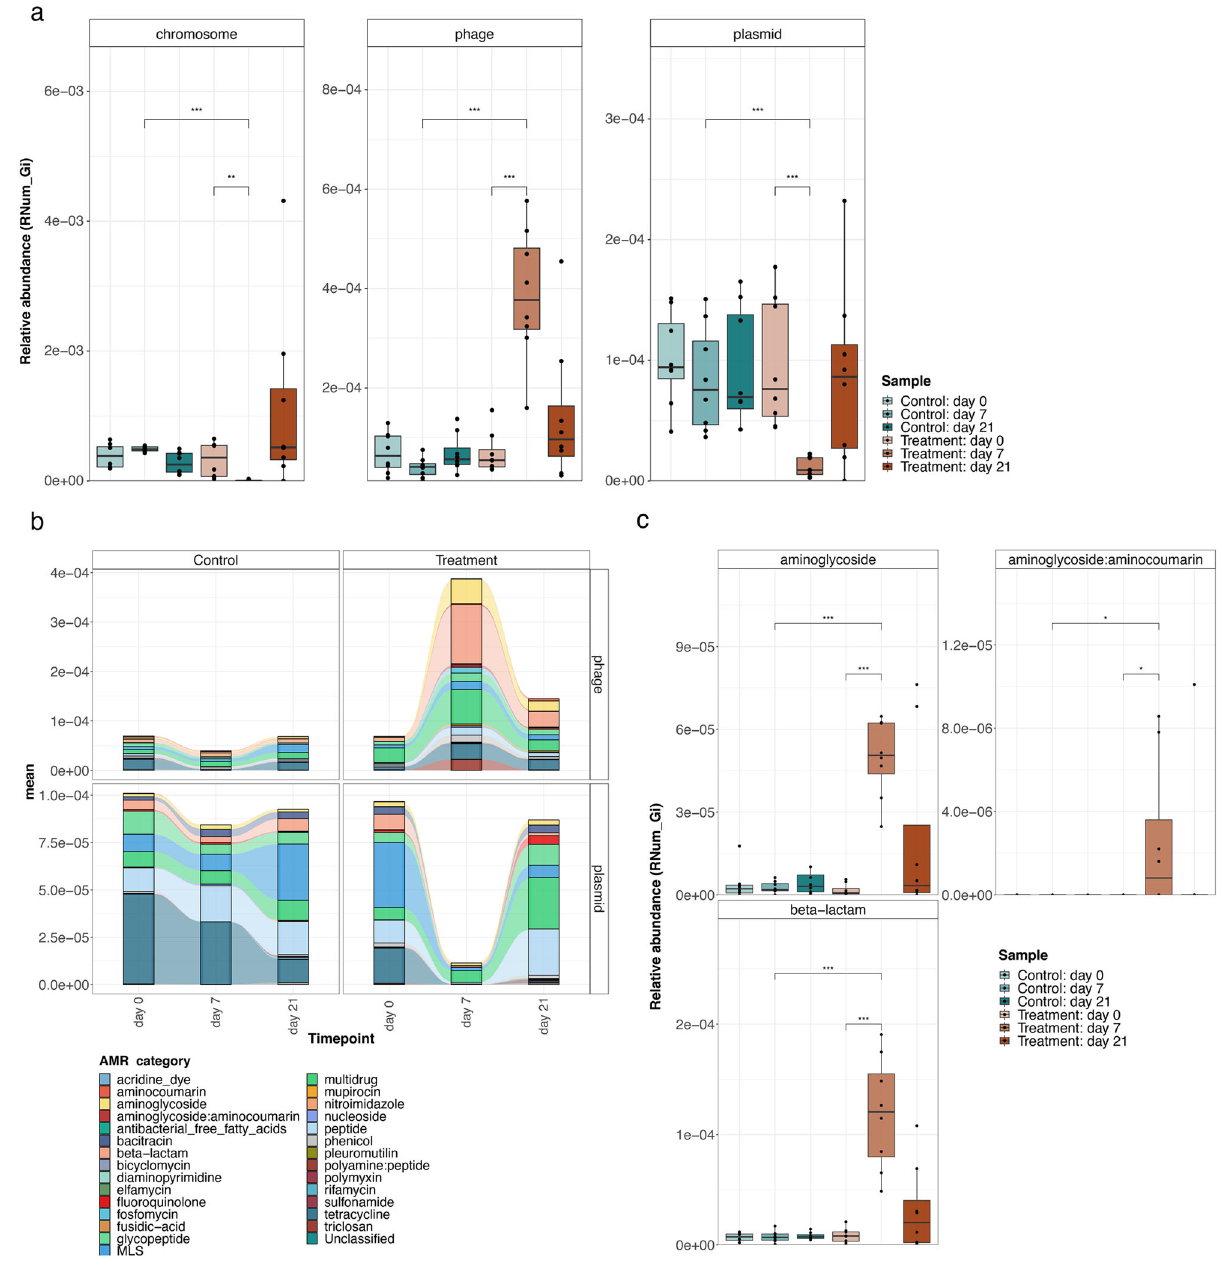
Fig. 3 Abundance levels of resistome categories. a Relative abundance of AMR encoded on the bacterial chromosome and those mediated via MGEs, such as bacteriophages (phages) and plasmids. n = 8 biological replicates per group. The center line denotes the median value (50th percentile), while the outer lines of the box represent the 25th – 75th percentiles. The black whiskers mark the 5th and 95th percentiles. Signi fi cance was assessed using a two-sided Wilcoxon rank sum test, where, p -values are indicated by *, i.e., * < 0.05, ** < 0.01, *** < 0.001. b Abundance levels of AMR categories disseminated via phages and plasmids. categories pre- and post-treatment (day 0 and day 21 respectively). c Abundance levels of aminoglycoside, aminoglycoside:aminocoumarin, and beta-lactam resistance genes mediated via phages in the control and treated mice ( n = 8 biological replicates). Signi fi cance was assessed using a two-sided Wilcoxon rank sum test, where, adjusted p -values are indicated by *, i.e., * < 0.05, ** < 0.01, *** < 0.001. The center line denotes the median value (50th percentile), while the outer lines of the box represent the 25th – 75th percentiles. The black whiskers mark the 5th and 95th percentiles. Source data are provided as a Source Data fi